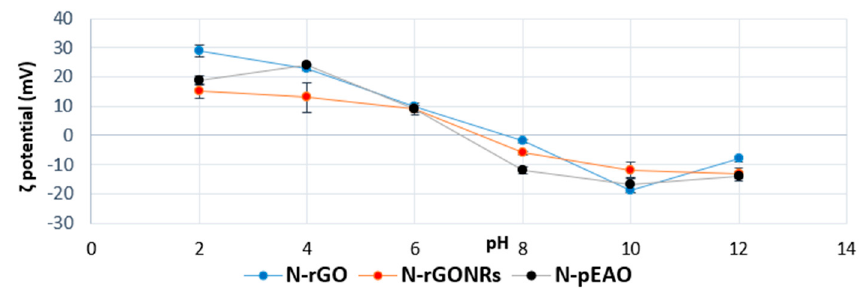
11 of 26 Figure 3. Evolved gas analysis done by TGA (black curve) coupled to MS fragments m/z 18 (H 2 O + ) (blue curve) and m/z 44 (CO 2+ ) (red curve) for ( a ) N ‐ rGO, ( b ) N ‐ rGONRs, and ( c ) N ‐ pEAO. N ‐ rGO, N ‐ rGONRs, and N ‐ pEAO water dispersions were examined further by ζ po ‐ tential measurement, which gives an indication of the stability of the colloidal system. The ζ potential curves in Figure 4 demonstrate the pH ‐ switching phenomenon observed for all three dispersions, which can be explained by the Derjaguin–Landau–Verwey–Over ‐ beek theory of colloidal dispersion. According to this theory, colloids tend to agglomerate or remain discrete, according to the net interaction from van der Waals attractions and electrostatic repulsions [20], where the large charge density increases the stability of dis ‐ persions by suppressing the aggregation process. The obtained data suggest the largest